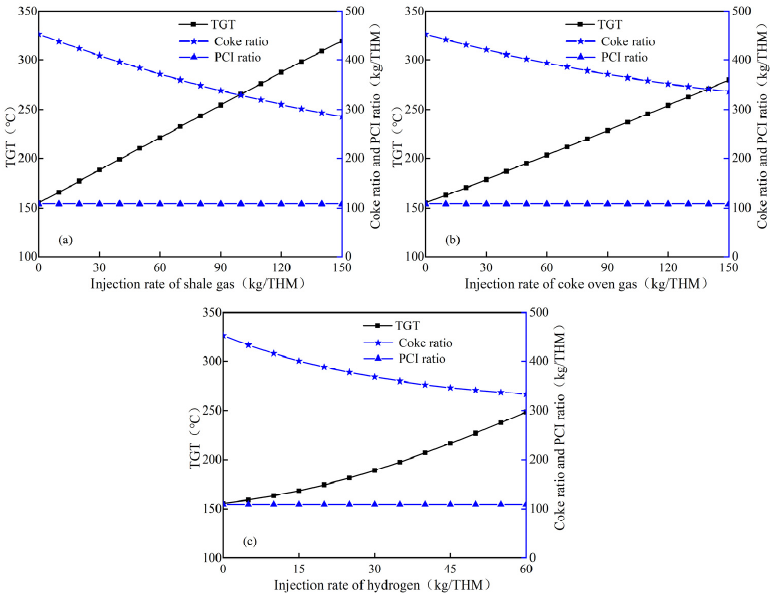
Figure 4. Influence of hydrogen − rich gas injection quantity on TGT: ( a ) shale gas; ( b ) coke oven gas; ( c ) hydrogen.